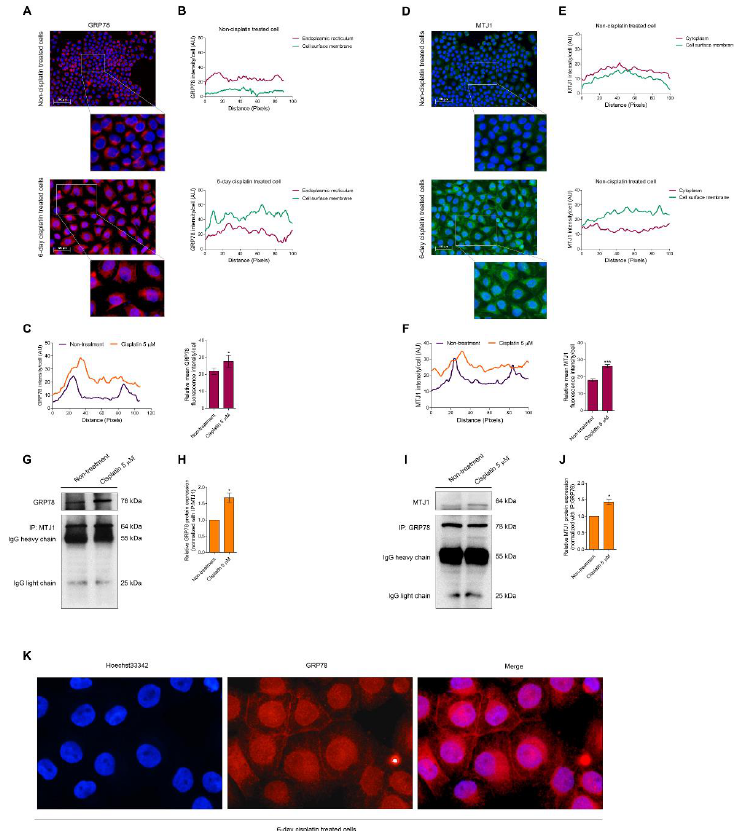
Figure 3. ( A , D ) The localization of GRP78 and MTJ1 was evaluated by an ICC assay in H460 non- treated cells and 6-day cisplatin treatment cells. ( B , E ) The fluorescent intensity of GRP78 at the nucleus and cell membrane was evaluated by ImageJ software. ( C , F ) The fluorescent intensity per cell was also measured. ( G , I ) The protein lysates of H460 and H460 senescent cells were collected and incubated with a mixture of beads and GRP78/MTJ1 primary antibodies to extract the protein of interest. Then, GRP78/MTJ1 protein levels were measured by Western blot analysis. ( H , J ) The densitometry of each protein level was demonstrated as a relative protein level. The protein levels of each protein were normalized with the protein levels of the pull-out protein. ( K ) The GRP78 protein was captured with 40 × magnification. Data represent the mean ± SEM ( n = 3) (* 0.01 ≤ p < 0.05 and *** p < 0.001, compared with the non-treated